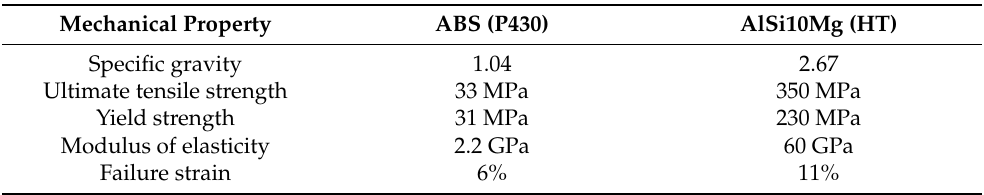
Figure 1. Decision tree for the proposed research investigation. Table 1. Mechanical properties of the ABS P430 and heat-treated AlSi10Mg measured parallel to the upright (ZX) building orientation, provided by Stratasys and EOS,